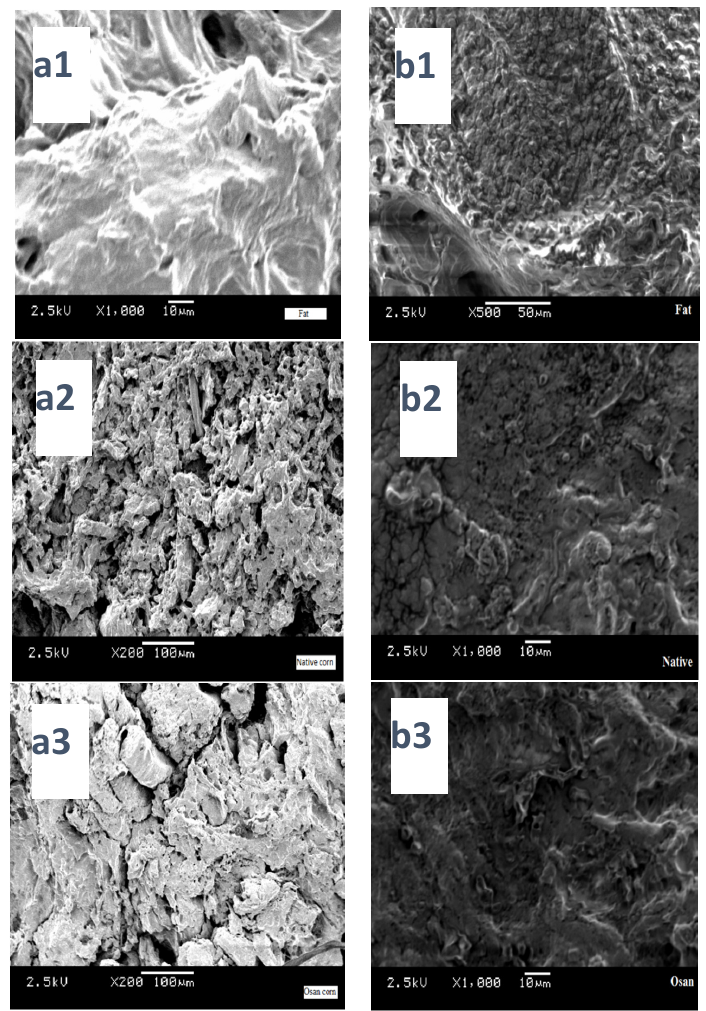
Figure 2. Scanning electron microscope (SEM) images of cooked patties containing animal fat, native corn starch and Osan corn starch ( a1 ) control, ( a2 ) native starch, and ( a3 ) Osam starch 15% addition; ( b1 ) control, ( b2 ) native starch, and ( b3 ) Osan 5% addition.